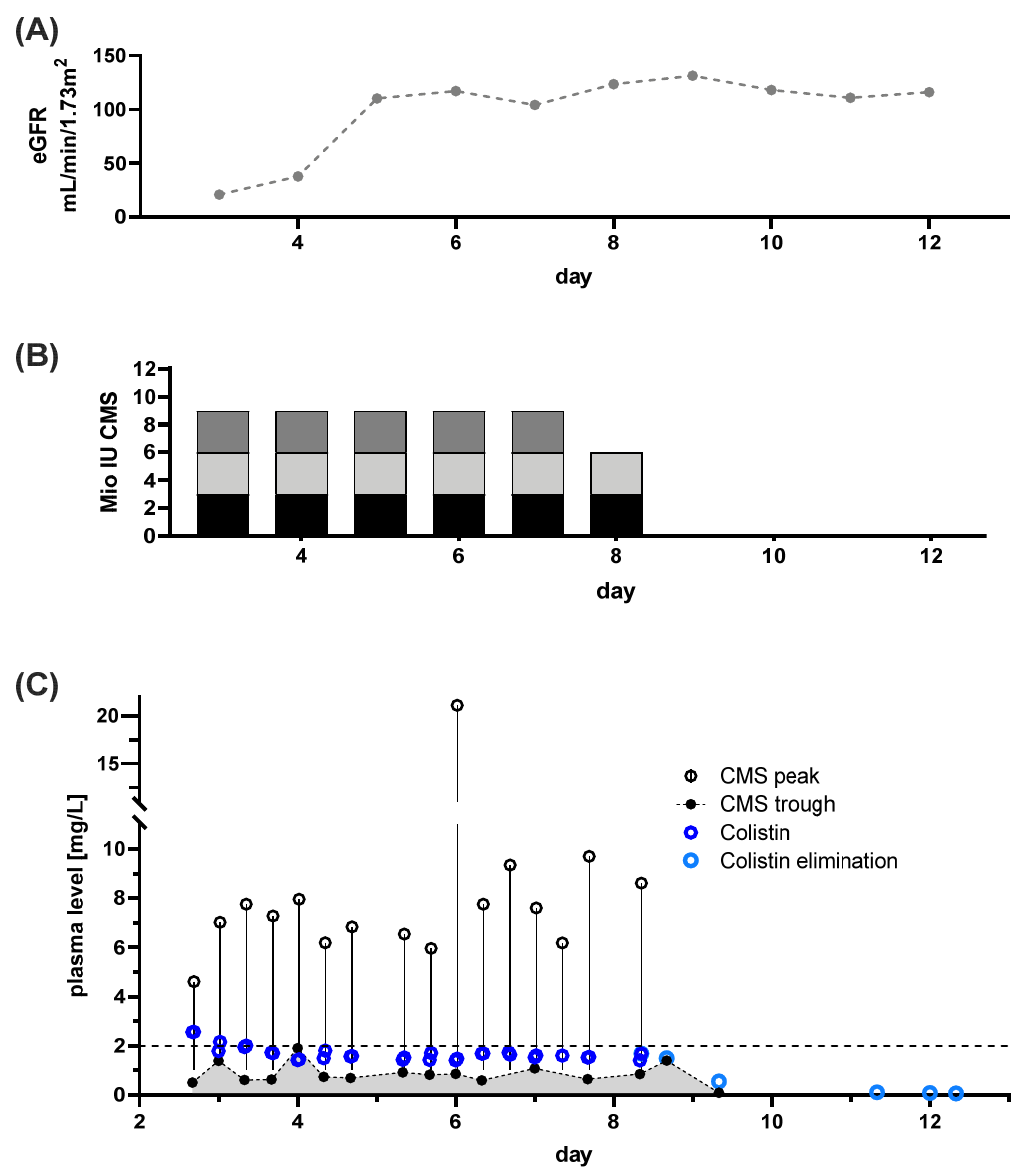
Figure 3. Renal function, dose regimen and drug plasma levels of patient 1: A total of 34 samples were analyzed (colisthimethate sodium (CMS) peak n = 16, CMS trough n = 16, Colistin peak n = 16, Colistin trough n = 20). ( A ) eGFR derived from serum creatinine levels is plotted at indicated treatment days. ( B ) Dosing regimen for CMS, colored portions indicate the particular doses during the day. ( C ) Time courses of CMS trough and peak levels along with Colistin levels. Colistin elimination was measured by continuing monitoring after the end of treatment (light blue dots) and the individual fitted elimination is plotted in Figure 1A. Target level for CMS is indicated by dashed line.